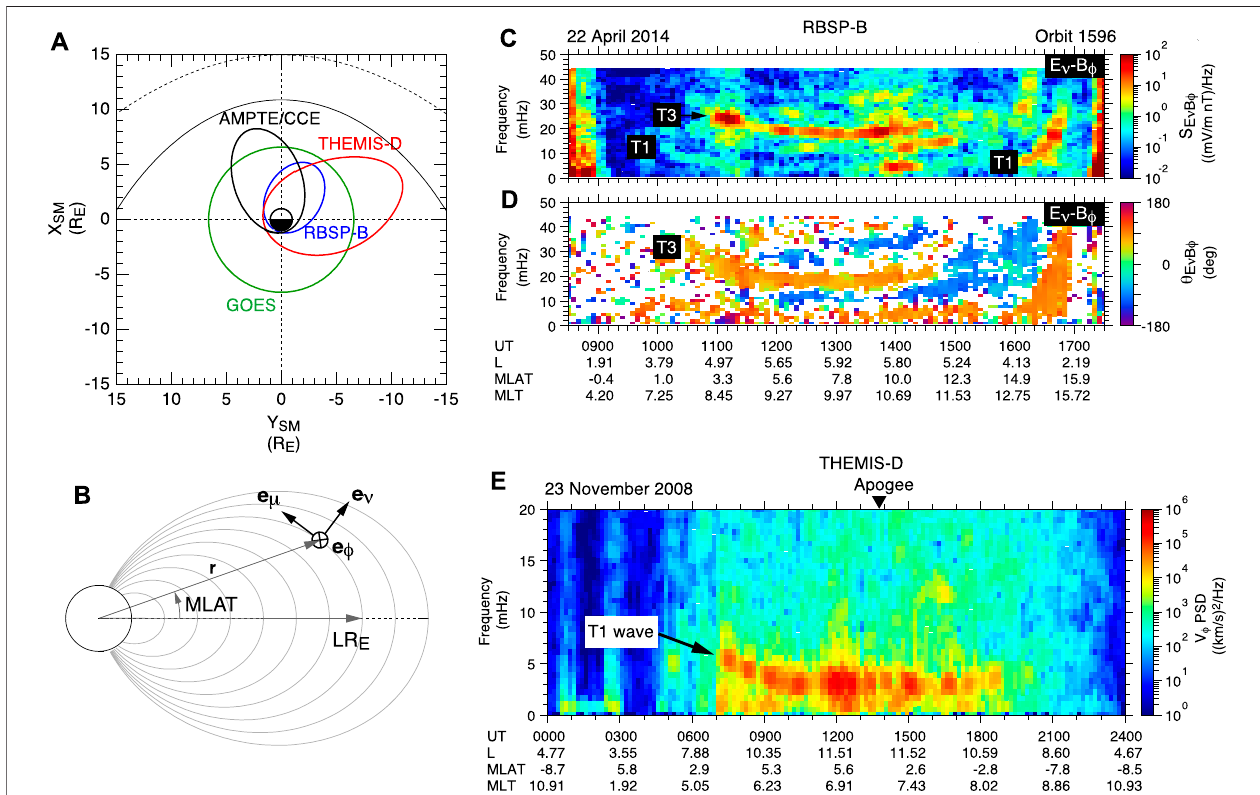
FIGURE 2 | Examples of orbital dynamic spectra showing toroidal waves. (A) Selected THEMIS-D and RBSP-B orbits. Orbits of GOES and AMPTE/CCE are included as a reference. (B) Coordinate systems for spacecraft positions and the observable vector quantities used in data analysis (C,D) Cross-power spectra and cross-phase spectra of the E ] and B ϕ components measured by RBSP-B (after Takahashi and Denton, 2021). (E) Dynamic spectra of the V ϕ component measured by THEMIS-D (after Takahashi et al.,